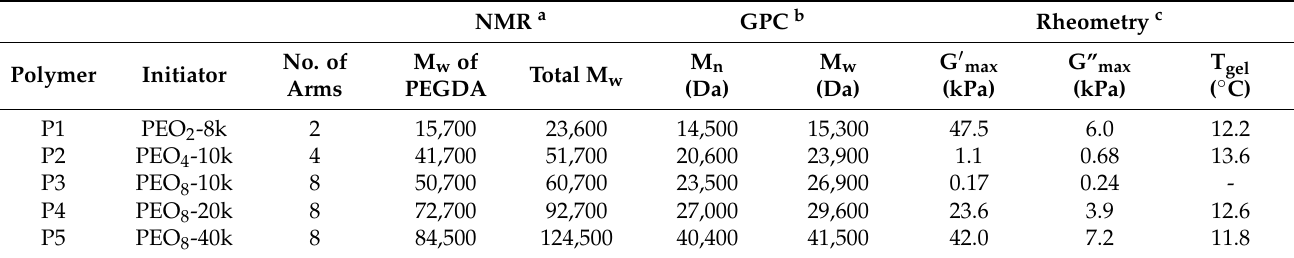
Table 1. Summary of the properties of the PEO- b -PDEGA star